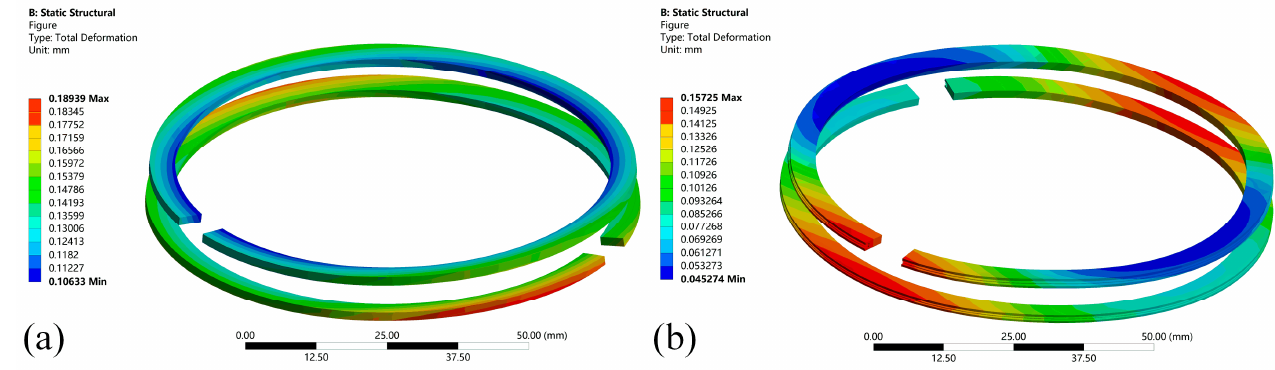
Figure 8. Deformation of piston ring group: ( a ) standard piston ring group and ( b ) piston ring No. 7 with groove texture.